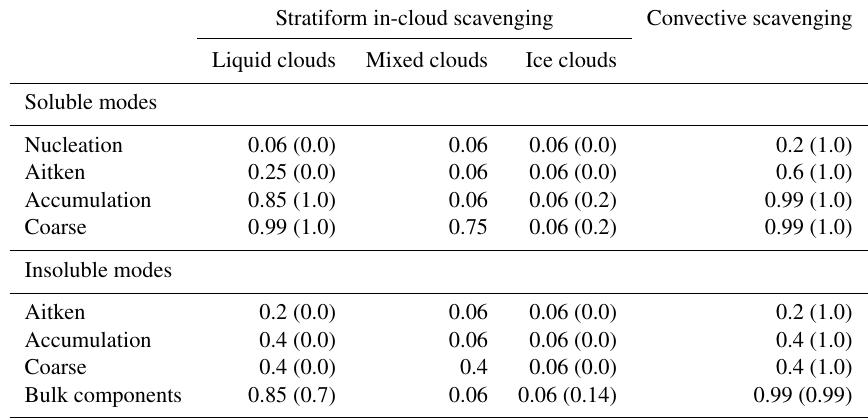
Table 2. Scavenging fractions for convective and stratiform in-cloud scavenging. The numbers in parentheses indicate the values used in the earlier TM5 and EC-Earth versions documented in van Noije et al. (2014). In those versions, the distinction between liquid, mixed, and ice clouds is made based on the cloud liquid and ice water content, and the scavenging fraction for mixed clouds depends on their ratio.